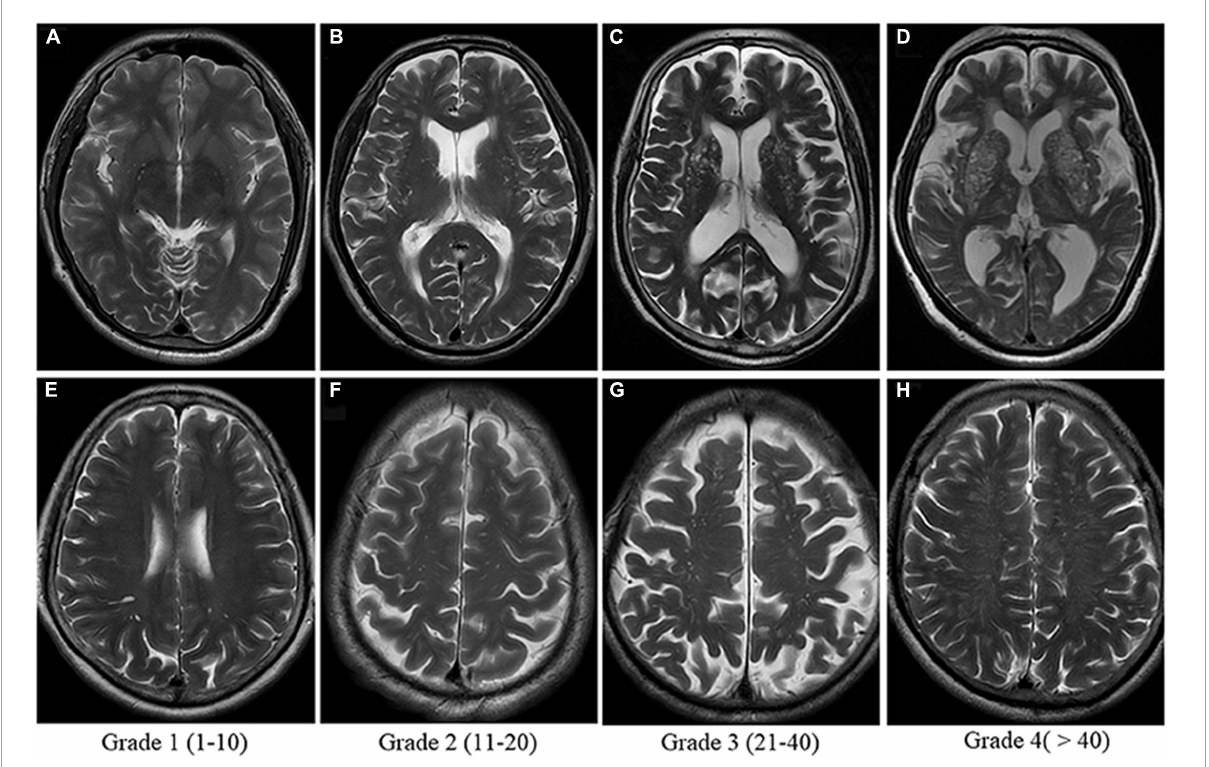
FIGURE7 Enlarged perivascular space (PVS) visual score rating as shown on T2-weighted MRI. Grades 2, 3, and 4 are considered abnormally enlarged. Panels (A–D) show severity of enlarged PVS in the Basal Ganglia. Panels (E–H) show severity of enlarged PVS in the centrum semi-ovale. The Basal Ganglia and Centrum Semi-Ovale are currently implicated as the most accurate measures of PVS burden. Image from Yu et al.